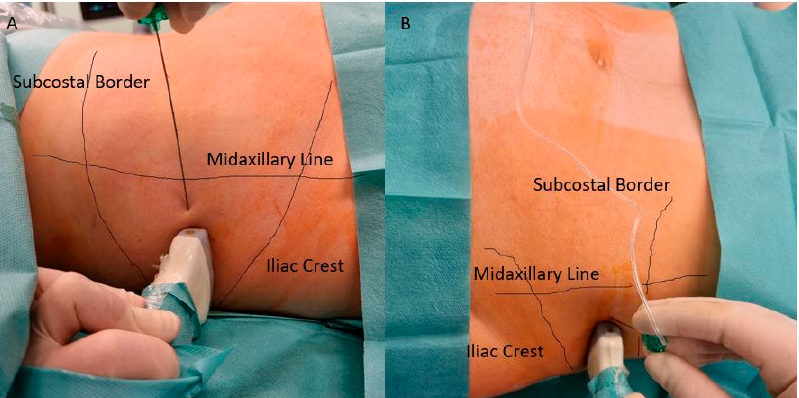
Figure 3. Site of administration of QLB and TAPB performed in the study. ( A ) Approach of administration of QLB; ( B ) Approach of administration of TAPB. Both blocks are performed between Illiac Crest and lower border of rib cage, below Midaxillary Line and guided under linear ultrasonography as presented in Figures 1 and